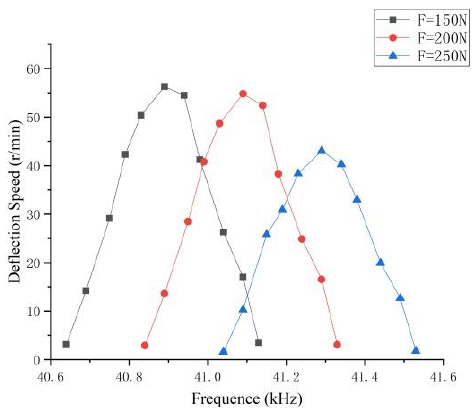
Figure 15. The influence of different pre-pressures on the motor speed. Table 3. Comparison of simulation results and experimental results. Figure 14. Output performance experimental test platform.